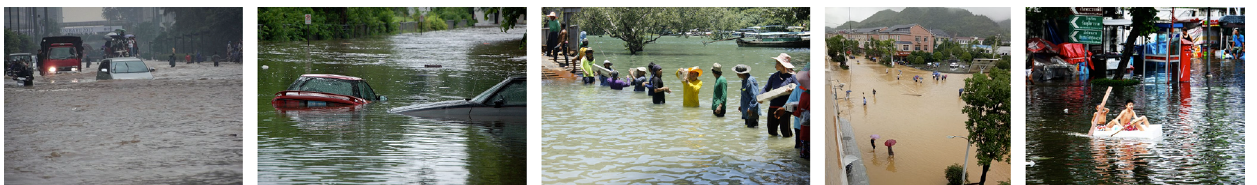
End-to-end training with 80% of images for up to 200 epochs Same as Basic Retrain Augmented network with seven manually labeled video